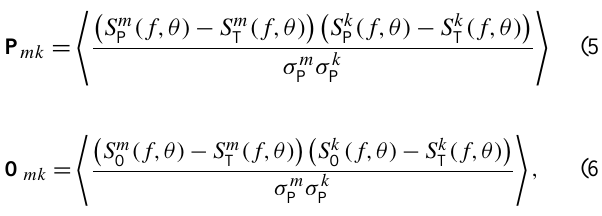
Fig. 1. Computational regions of the model and locations of data buoy stations.